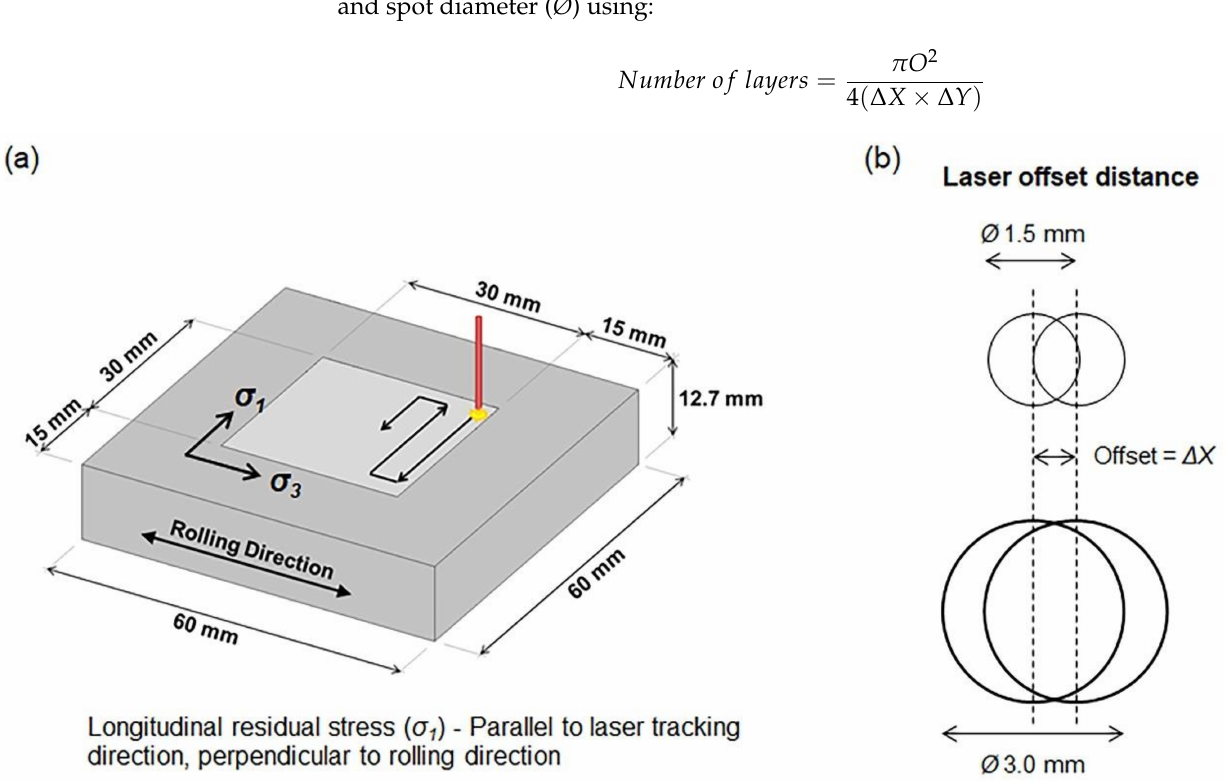
Figure 2. Schematic of the laser scanning strategy of the multiple-shot patch data with overlap showing ( a ) dimensions of test coupons and definition of the axis system. Residual stresses denoted as σ 1 are parallel to the laser tracking direction and perpendicular to the rolling direction. ( b ) Laser offset distance ∆ X was measured from centre-to-centre points of each laser